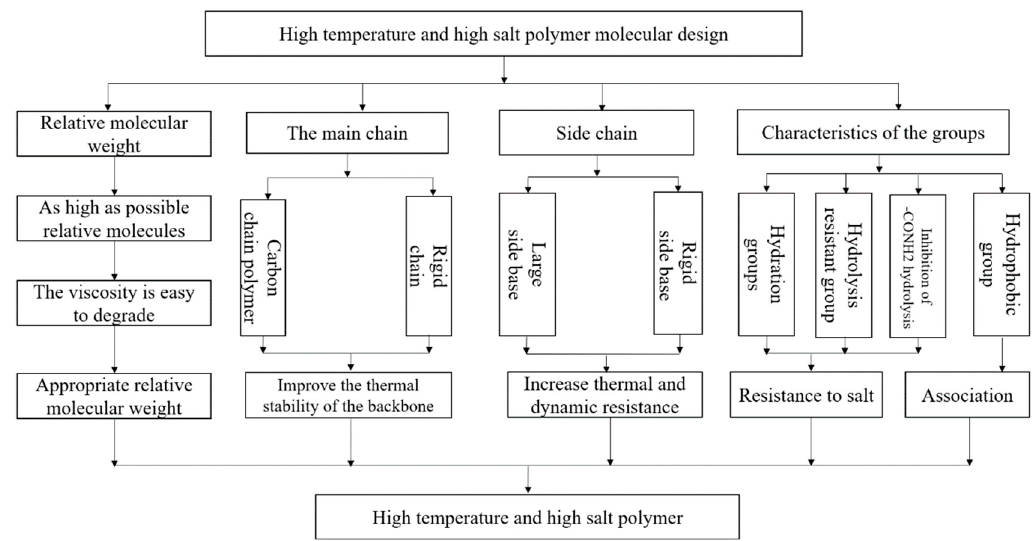
Figure 1. Diagram of the polymer